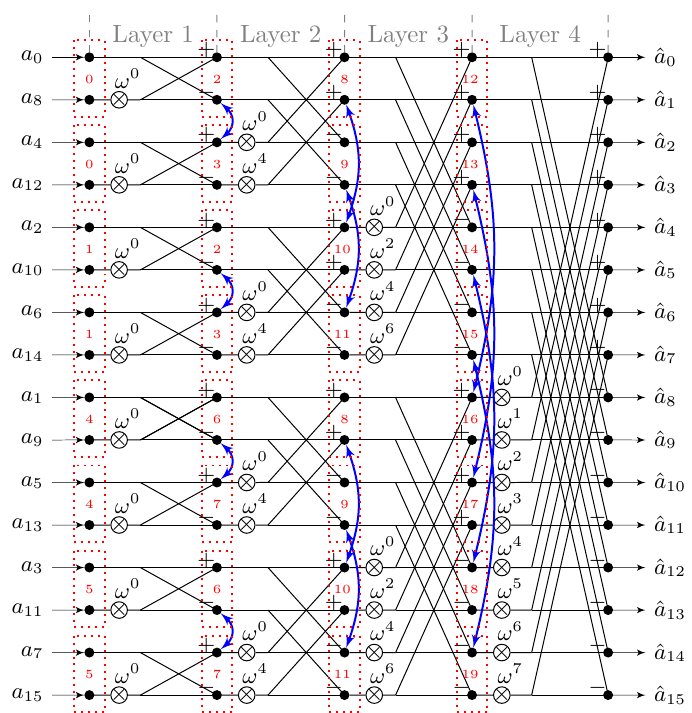
Figure 1: Example NTT CT with n = 16. In this case, two coefficients are stored in br ← no a single word, eight coefficients can be loaded to the register file ( l = 8), and two pairs of coefficients can be executed in parallel. The red boxes indicate which coefficients are stored together in one word and in which order the coefficients are processed by the two butterfly units. The blue arrows show the coefficients which are swapped after the butterfly operations. For l = 8, log 2 ( l ) − 1 = 2 layers were merged.